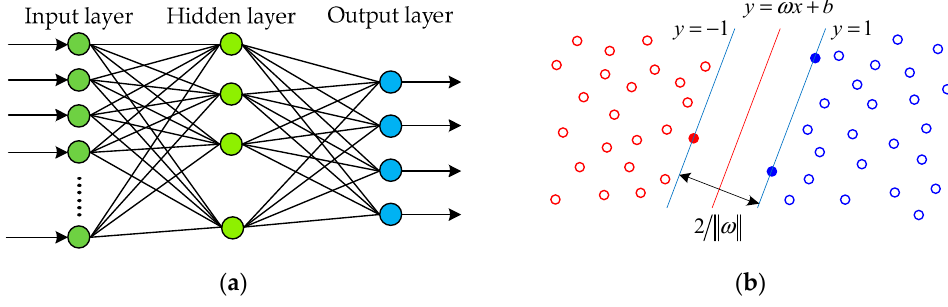
Figure 10. Structure of two types of classifiers, ( a ) NN with one hidden layer; ( b ) SVM [109].